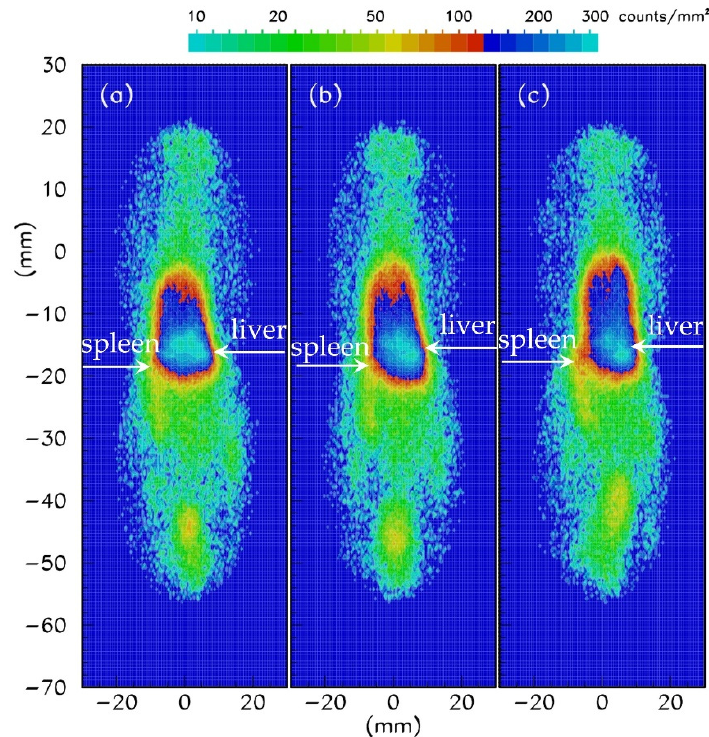
Figure 5. ( a – c ) Representative coronal gamma camera images of a normal Swiss mice intravenously injected with [ 99m Tc]Tc-DPD-Fe 3 O 4 DMCA at a final concentration of C DMCA = 0.01 mg/mL. The images were obtained at ( a ) 1, ( b ) 2 and ( c ) 4 h p.i.